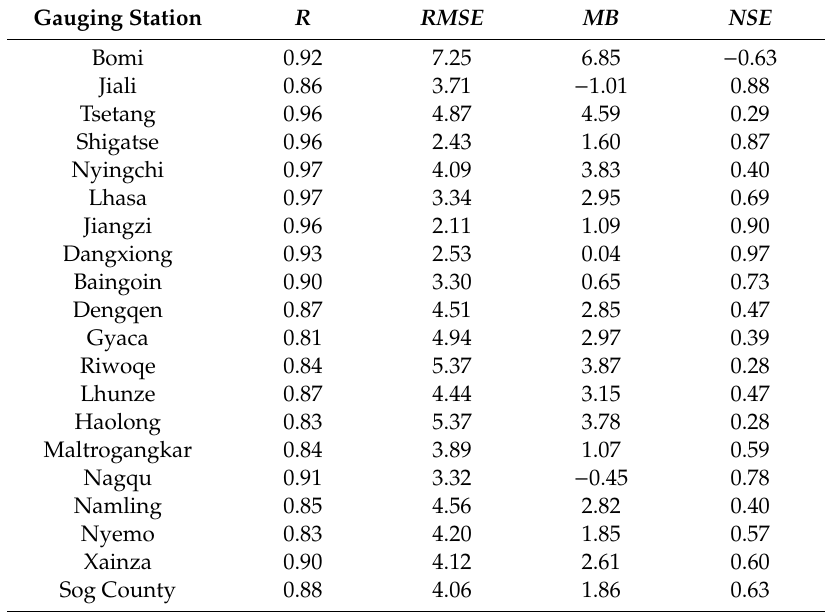
Table 3. Statistical indicators of temperature between the GLDAS-NOAH and gauging